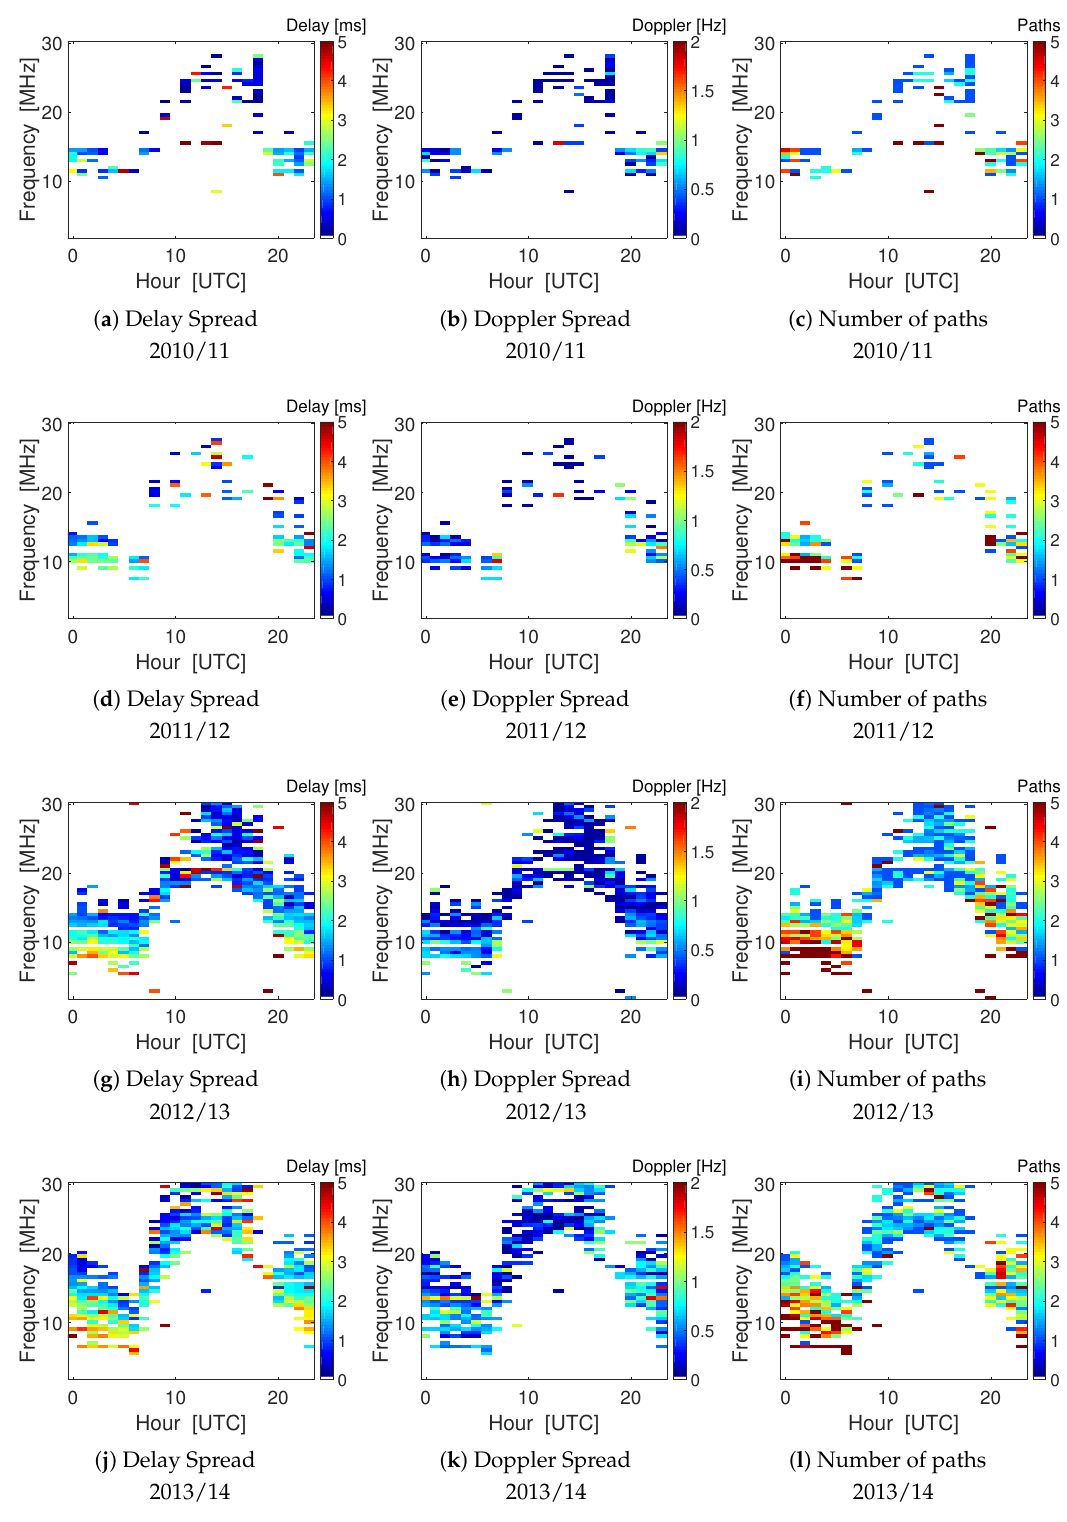
Figure 7. Comparison of the metrics of the four campaigns under study. First row, Campaign 2010–11: ( a ) mean delay spread; ( b ) mean Doppler spread and ( c ) mean number of paths. Second row, Campaign 2011–12: ( d ) mean delay spread; ( e ) mean Doppler spread and ( f ) mean number of paths. Third row, Campaign 2012–13: ( g ) mean delay spread; ( h ) mean Doppler spread and ( i ) mean number of paths. Fourth row, Campaign 2013–14: ( j ) mean delay spread; ( k ) mean Doppler spread and ( l ) mean number of paths. All delay spreads are measured in ms, and all Doppler spread are measured in